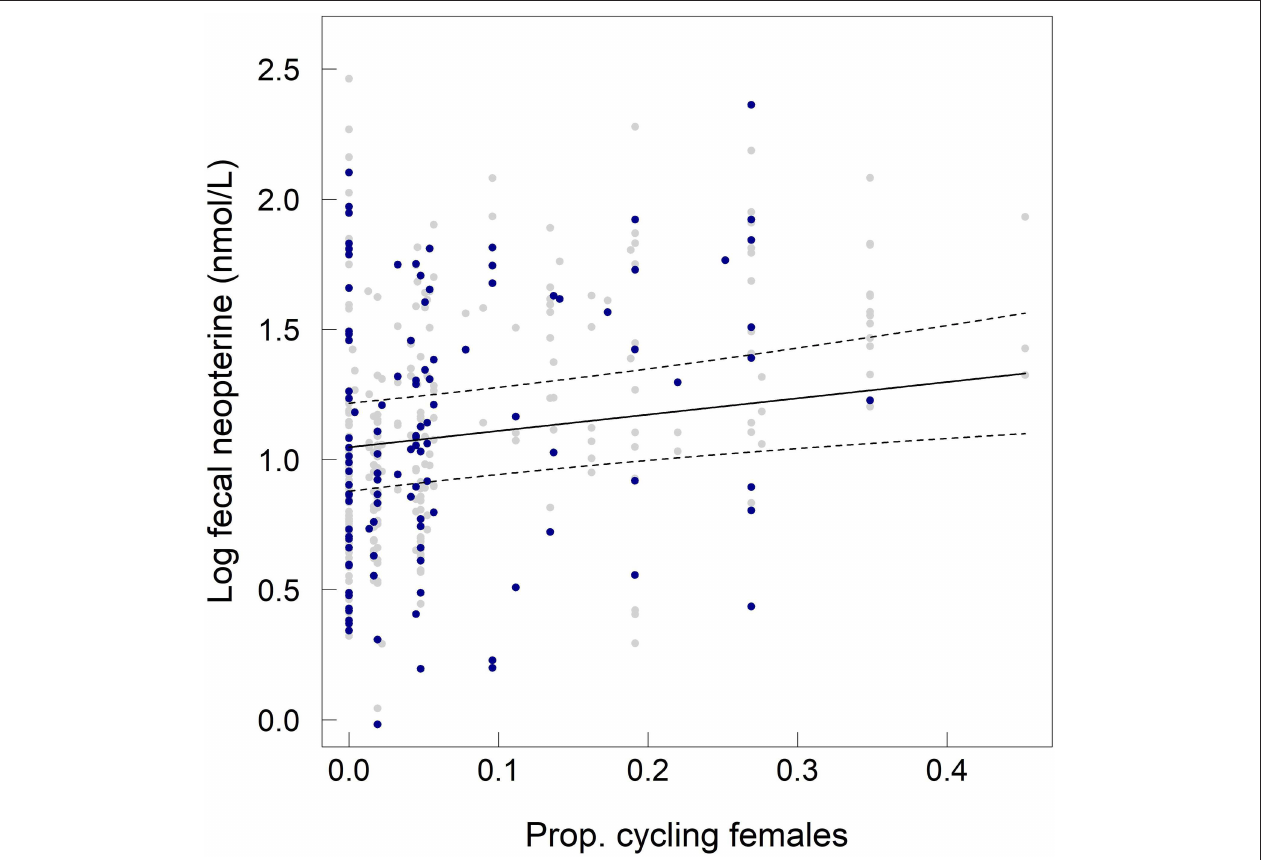
FIGURE 2 | Influence of the proportion of cycling females in the group on fecal neopterin concentrations (log-transformed) across individuals of both sexes and all ages. Gray dots represent the raw values for adult individuals, blue dots represent the raw values for non-adult individuals and the solid line represents the predicted values of the model including all individuals. The dashed lines represent the 95% confidence intervals of the predicted values.